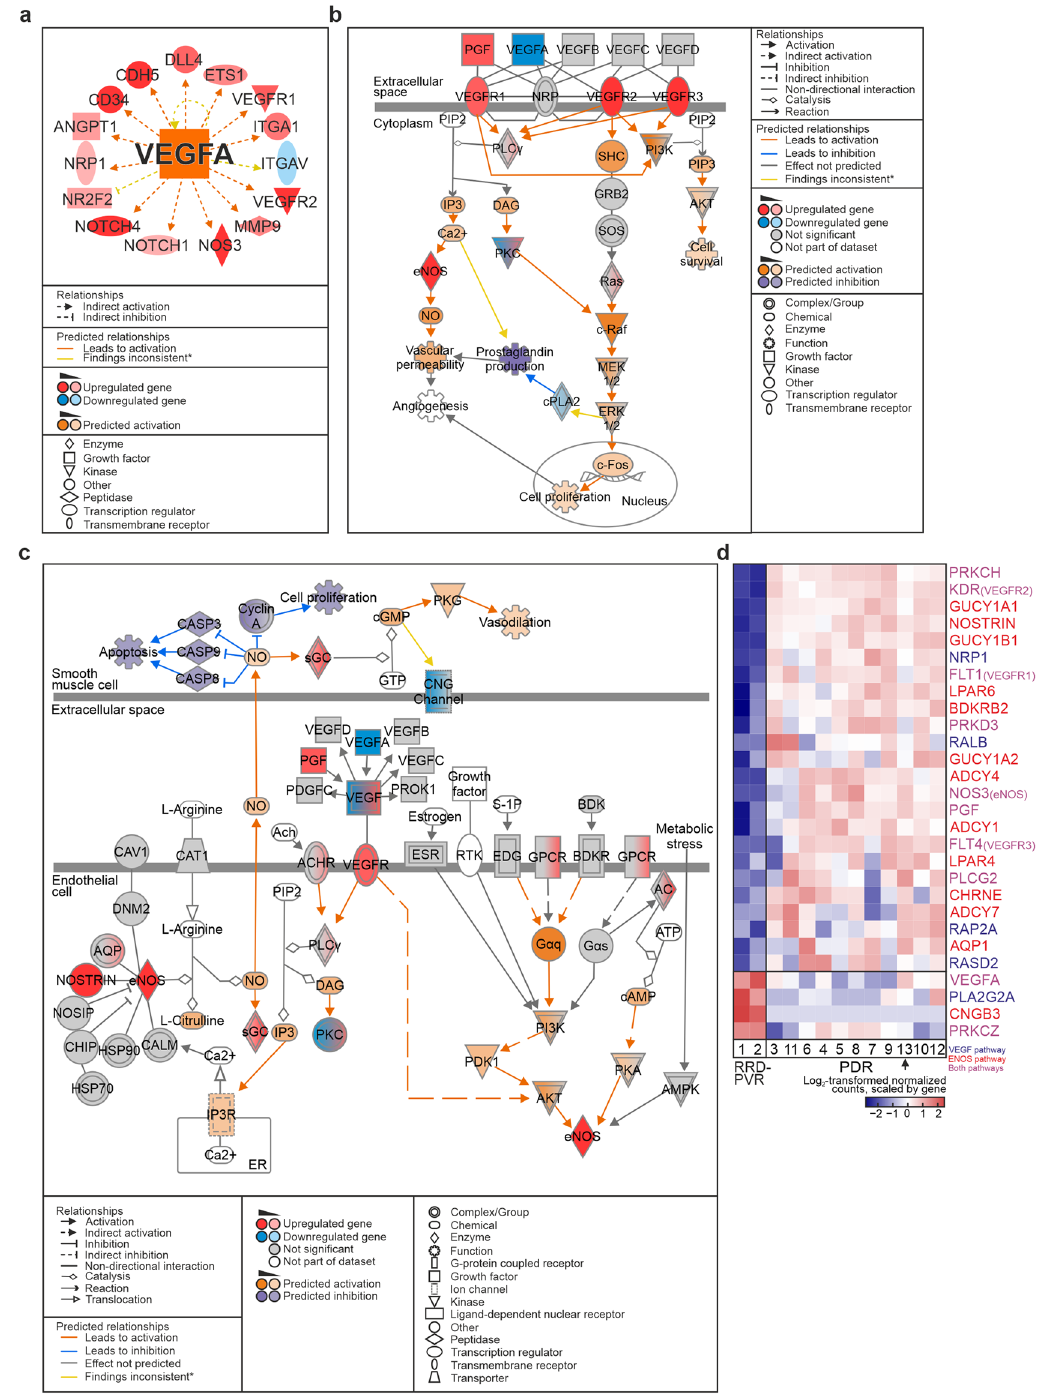
Figure 3. VEGFA-ligand-dependent mechanisms are involved in proliferative diabetic retinopathy. ( a ) Network of DEGs affected by VEGFA (Ingenuity Pathway Analysis (IPA)), based on which VEGFA was predicted as an activated upstream regulator. ( b ) IPA canonical pathway VEGF family ligand receptor interactions. ( c ) IPA canonical pathway Enos signalling . ( d ) Heatmap of log 2 -transformed normalized read counts of DEGs in VEGF family ligand receptor interactions and Enos signalling IPA canonical pathways. Genes in VEGF family ligand receptor interactions , Enos signalling or both pathways are indicated in blue, red, and purple, respectively. Arrow indicates the PDR patient who had received no preoperative retinal laser photocoagulation (Patient 13). (*) Yellow arrows in ( b ) and ( d ) indicate that findings are inconsistent with the state of downstream molecule (IPA). The network and pathways in ( a ), ( b ) and ( c ) were generated through the use of IPA (QIAGEN Inc., https:// www. qiage nbioi nform atics. com/ produ cts/ ingen uity- pathw ay- analy sis) 45